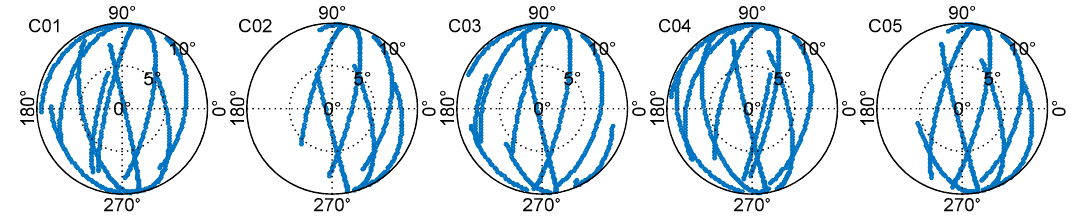
Figure 2. Zenith and azimuth series variation of vectors from FY-3C positioning antenna to the transmitter antenna of BeiDou GEO in the GEO orbital reference frame during 14 July 2017.